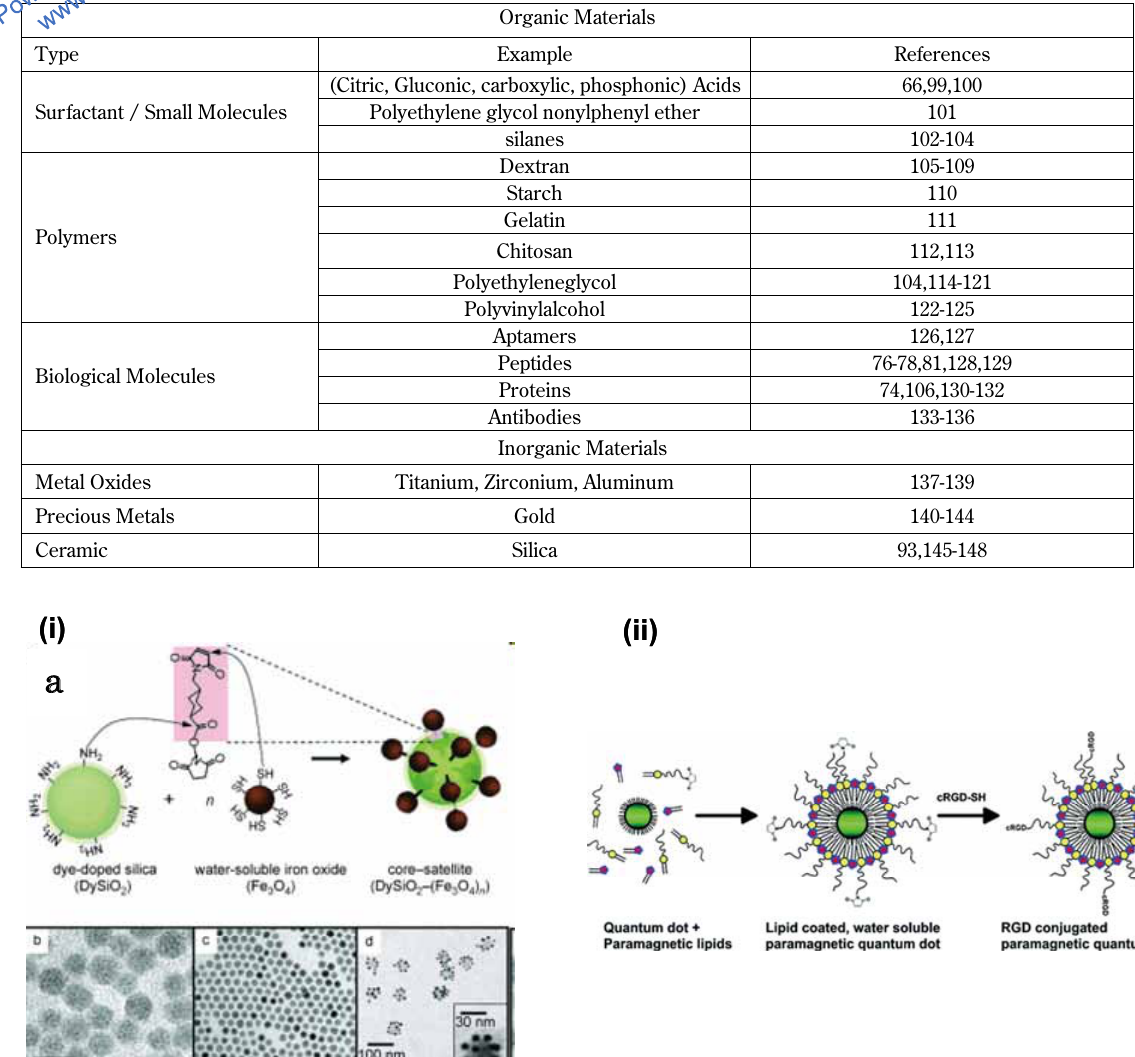
), c) iron oxide (Fe 2